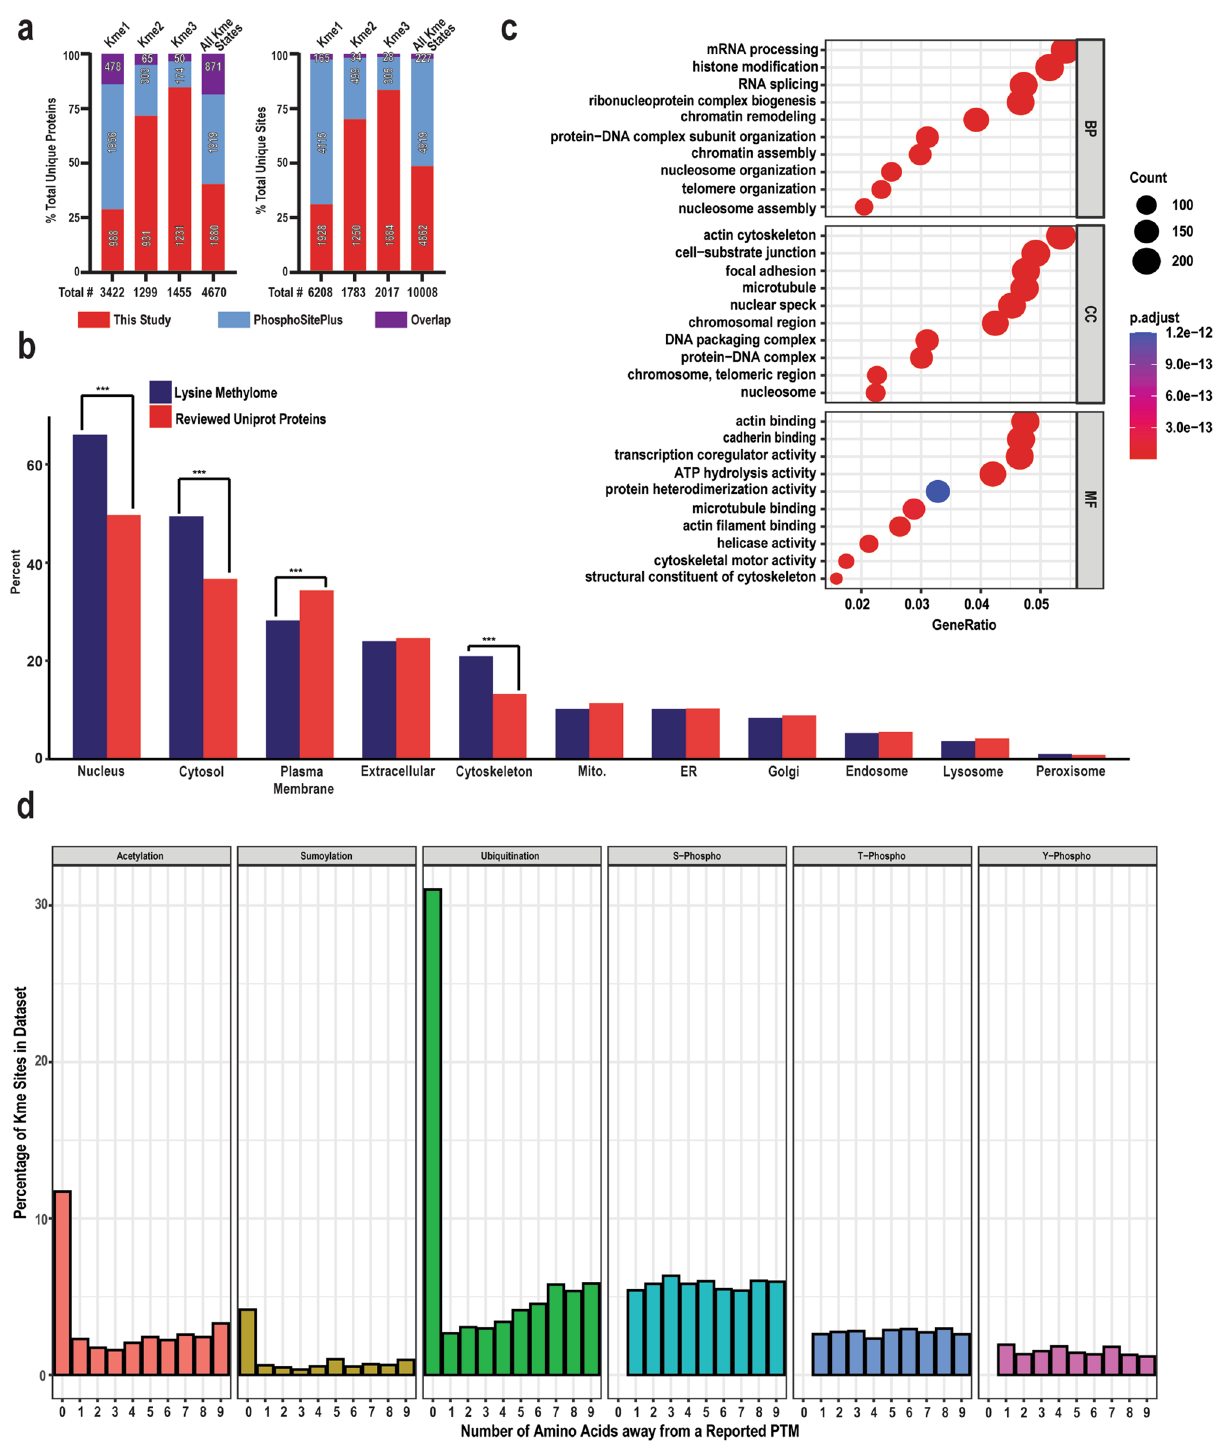
Figure 6. The landscape of the expanded lysine methylome. ( a ) Number of unique proteins and unique lysine methylation sites in the human lysine methylome and the percentage of sites identified in this study and those previously identified and recorded in the PhosphoSitePlus database. ( b ) Subcellular localization of all lysine methylated proteins compared to all human proteins (reviewed UniProt). (***) represents a p value < 2.0 e−16. ( c ) Over-representation analysis of all proteins with lysine methylation using the enrichGO function from the “clusterProfiler” package in R. Enriched ontologies—biological processes (“BP”), cellular compartments (“CC”), and molecular functions (“MF”)—identified using p. adjusted method of FDR with a cutoff of 0.05. ( d ) Analysis of the potential for PTM crosstalk. Percentage of Kme sites within 9 amino acids of another identified PTM (total sites, n = 10,413). All known acetylation, sumoylation, ubiquitination, and phosphorylation sites deposited from PhosphoSitePlus were used. Phosphorylation is subset by serine, threonine, and tyrosine